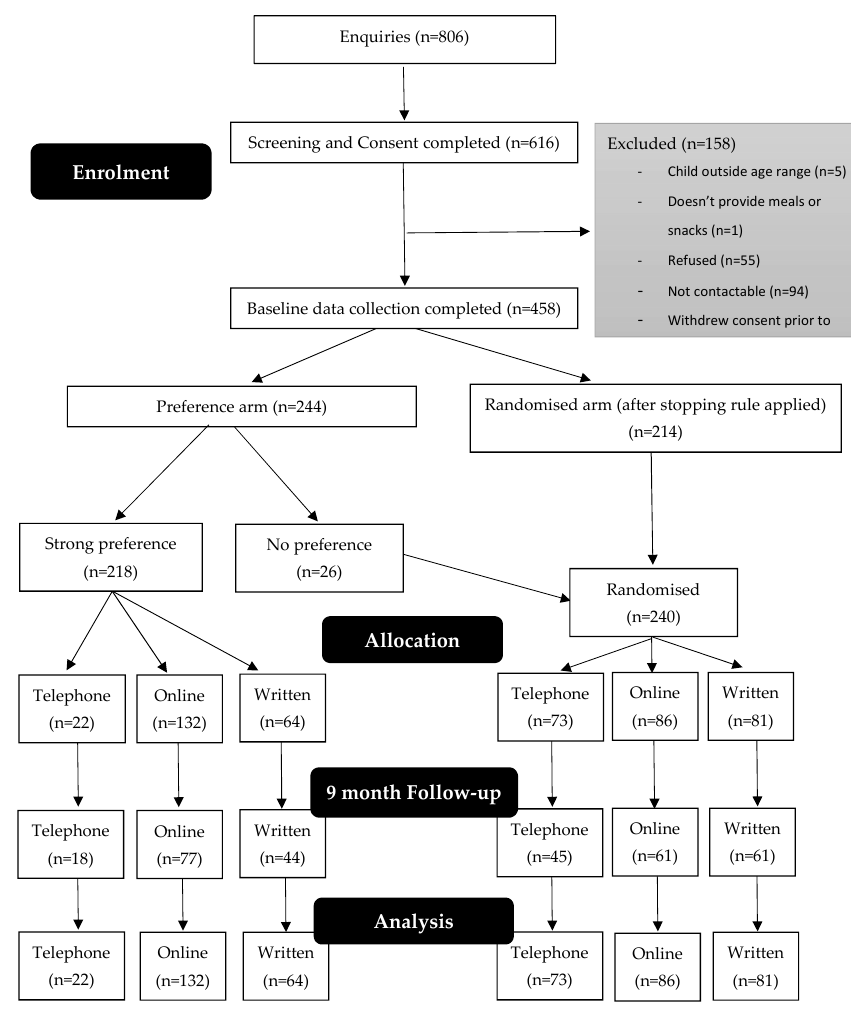
Figure 1. CONSORT flow diagram for the Time for Healthy Habits